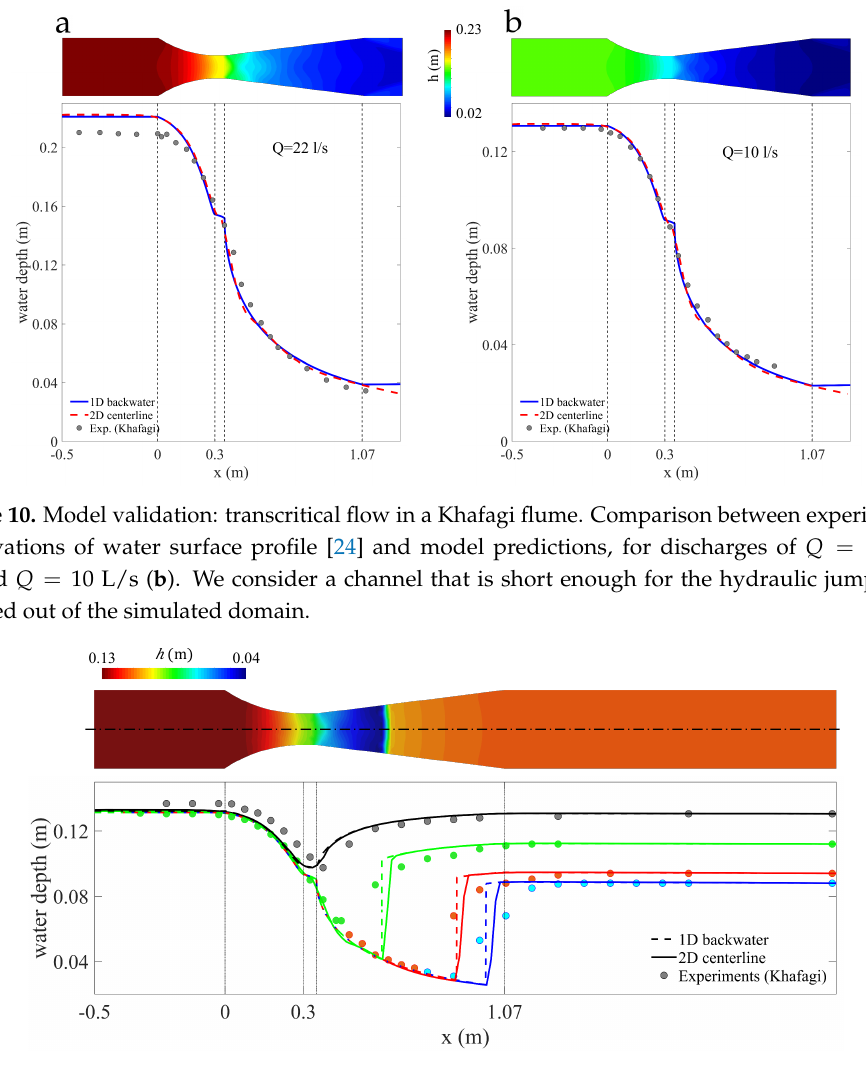
Figure 11. Transition to subcritical flow in Khafagi’s experiments [24]. We illustrate the comparison between model predictions and experimental results using the discharge Q = 10 L/s. Hydraulic jumps are described as shocks by the models, and as smooth water surface variations in the experimental data, due to the complex internal structure of the roller in the jump region. We use solid lines for profiles along the channel axis in 2D simulations, broken lines for the 1D theory, and circles for the experimental measurements. Line colors correspond to different imposed tailwater